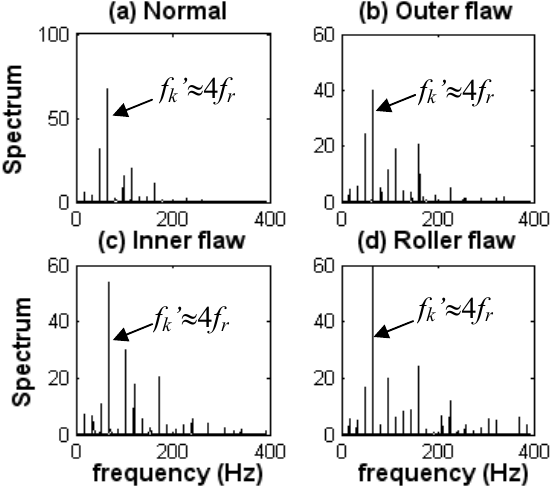
Figure 11. Envelope spectra of diagnosis signals in each state. (a) Normal state. (b) Outer- race flaw state. (c) Inner-race flaw state. (d) Roller flaw